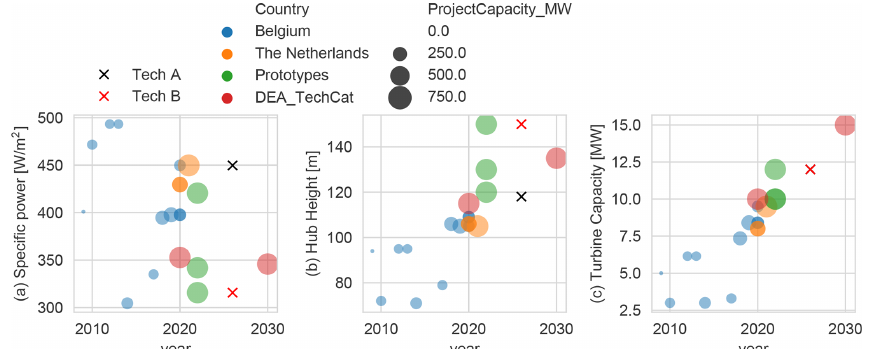
Figure 1. Trends in specific power, hub height, and turbine capacity for offshore turbines.